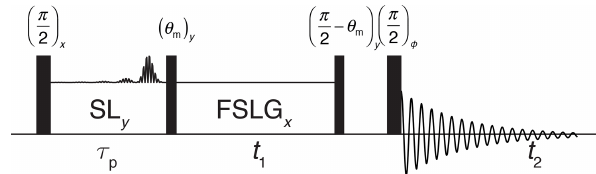
Figure 6. Schematic representation of the pulse sequence used to acquire two-dimensional proton–proton chemical-shift correlation spectra with high resolution through FSLG decoupling achieved in t 1 . The final 90 ◦ pulse is phase cycled together with the receiver through all four quadrature phases. States-type phase-sensitive de- tection in the indirect dimension is implemented by shifting the phase of the first 90 ◦ pulse and the spin lock by 90 ◦ . To select parts of the sample by the I-BURP-2 pulse in the spin-lock frame, two scans with and without the inversion pulse were subtracted by shift- ing the receiver phase by 180 ◦ .